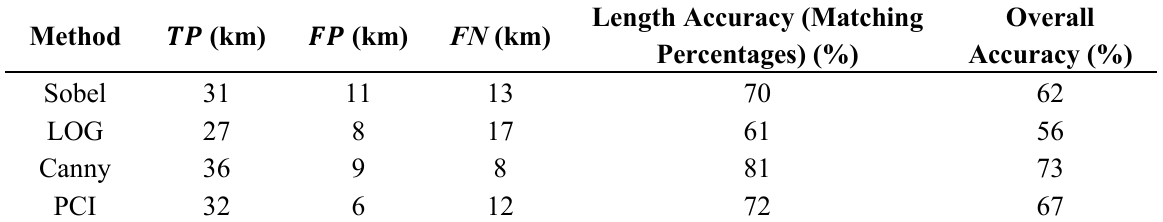
Table 3. Quantitative measures obtained by TecLines and PCI for panchromatic band of QuickBird-2. True positive (TP) is the number of correctly extracted discontinuities. False positive (FP) is the number of line segments erroneously classified as discontinuities. False negative (FN) is the amount of line segments that were not classified as